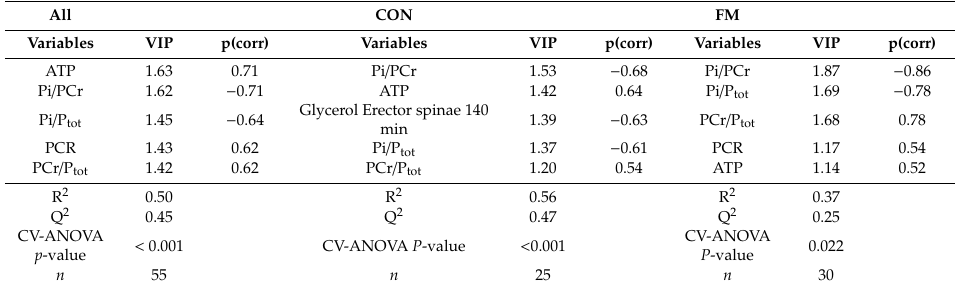
Table 9. OPLS regressions of blood flow at baseline (140 min) in erector spinae in all subjects taken together, in CON, and in FM. Regressors used data from spectroscopy and MD data from baseline of this muscle (except pain variables from microdialysis). Only significant variables are shown (i.e., variables with VIP > 1.0 and absolute p(corr) ≥